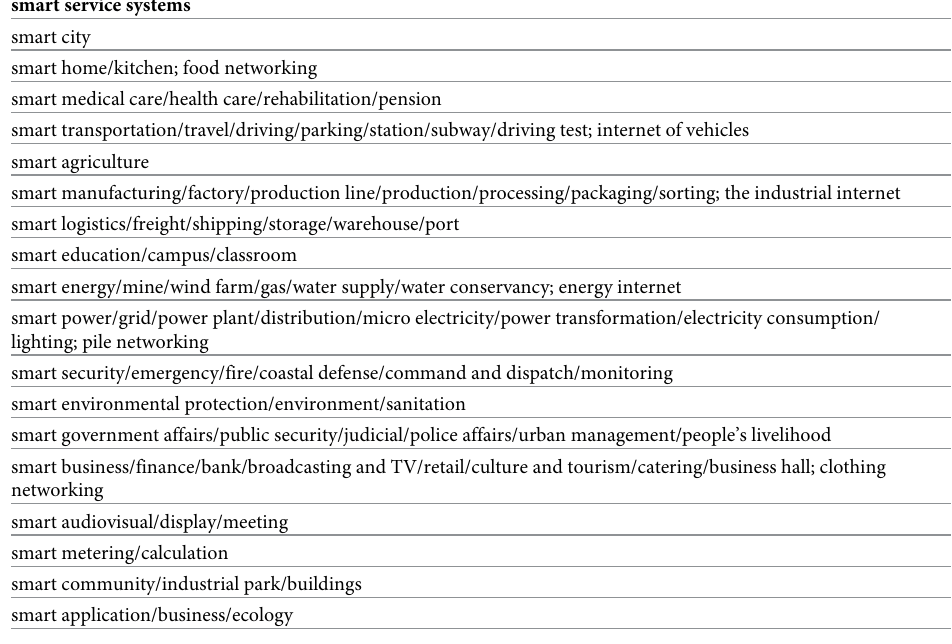
Table 1. Keywords of smart